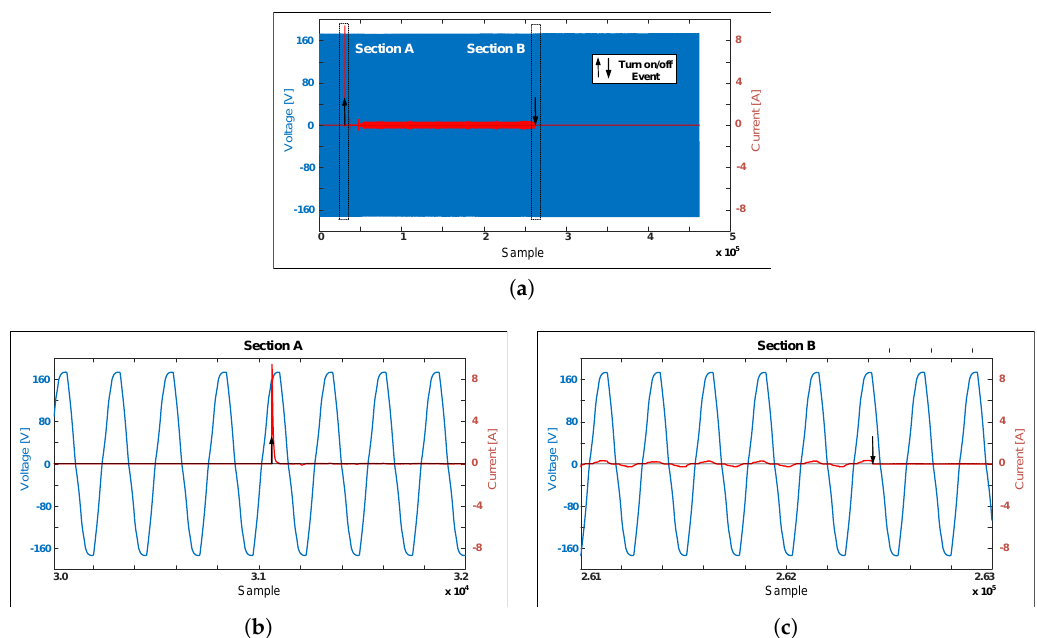
Figure 13. Jig acquisition of a single load: laptop power supply—trigger angle of 45 degrees. ( a ) Complete acquisition—AC mains voltage and current. ( b ) Turn-ON event. ( c ) Turn-OFF event.